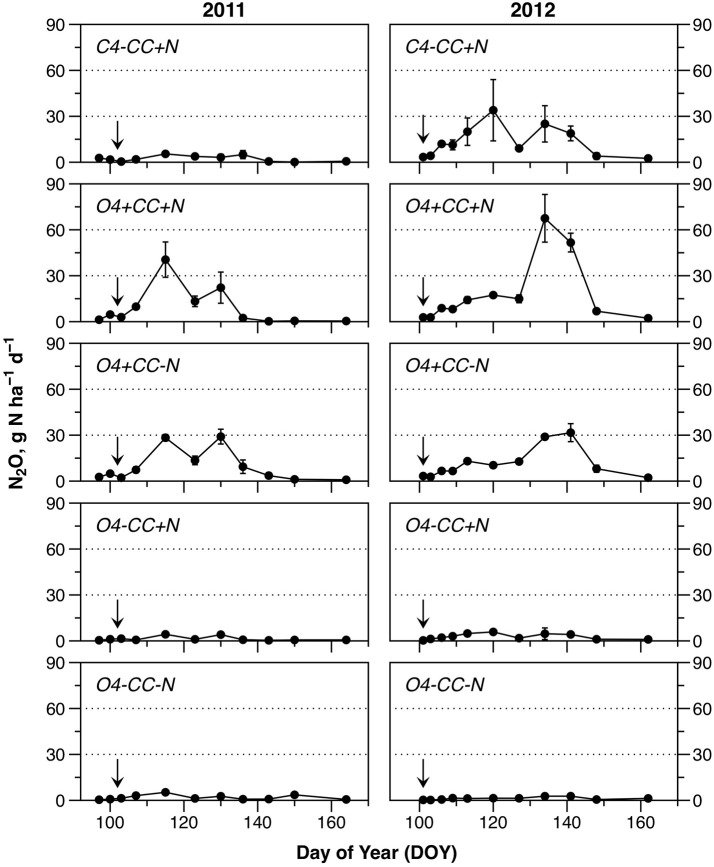
Nitrous oxide emissions during the monitored periods in 2011 and 2012. Fertilization took place on April 12 (DOY102) in 2011 and April 10 (DOY101) in 2012 (indicated by arrows). The data represent means of four observations in two replicate plots, while error bars represent standard error (n = 2).